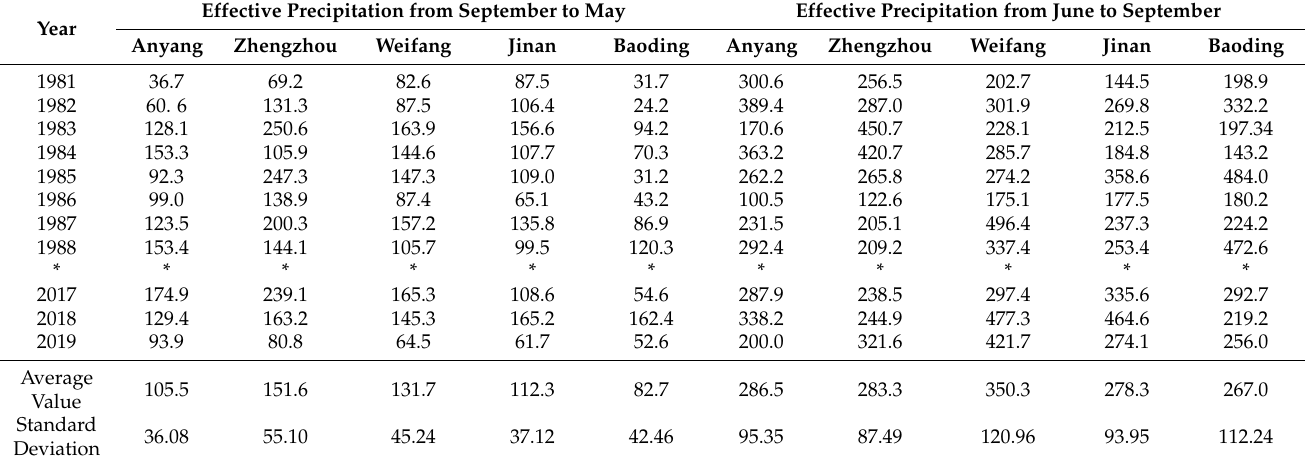
Table 4. Annual effective precipitation (mm) during the growth period of winter wheat and summer maize in the past 40